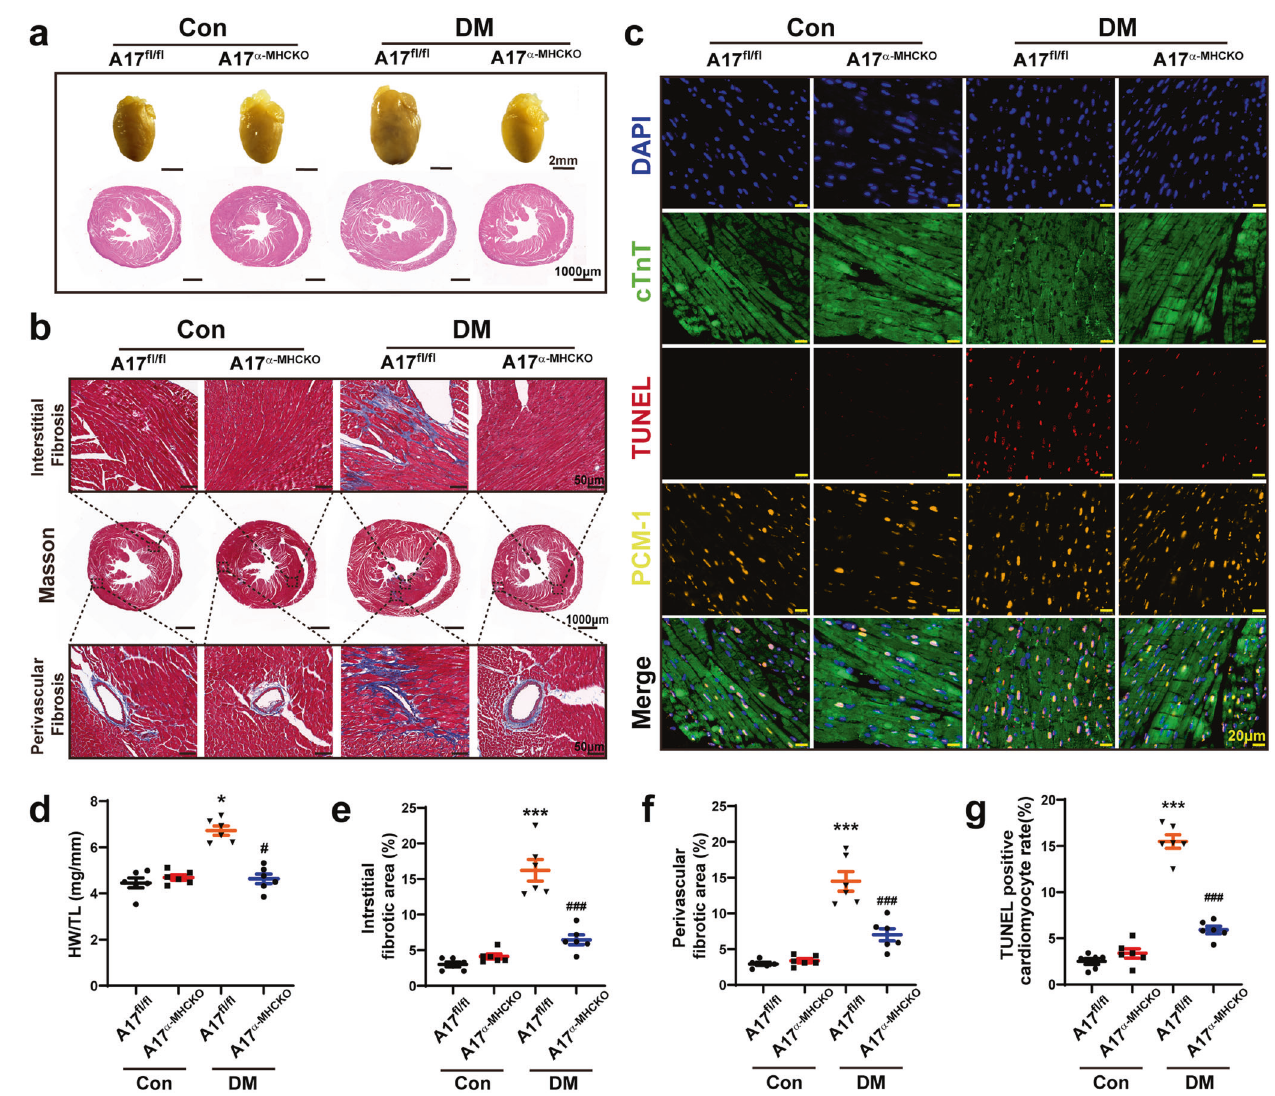
Fig. 2 Histological and immunohistochemical staining in four groups of mice. a Representative images of hearts and myocardial cross- sections in four groups of mice: representative heart pictures (scale bar: 2 mm) were shown in the upper panel; Representative H&E staining of myocardial cross-sections (scale bar: 1000 μ m) were shown in the lower panel. b Representative Masson ’ s trichrome staining of myocardial fi bers. Masson ’ s trichrome staining of cardiac short-axis cross sectional areas (scale bar: 1000 μ m) were shown in the middle panel. Dotted boxes in the middle panel indicated a local area in the low magni fi cation fi eld (scale bar: 1000 μ m), which was enlarged in the high magni fi cation fi eld (scale bar: 50 μ m) in the bottom panel. The interstitial fi brosis images were shown in the top panel and the perivascular fi brosis images were shown in the bottom panel. c Representative TUNEL-positive cardiomyocyte staining in mice (scale bar: 20 μ m). d Quantitative analysis of heart weight/tibial length (HW/TL) ratio in mice, n = 6. e and f Quanti fi cation of the interstitial and perivascular fi brosis area in mice, n = 6. g Quanti fi cation of TUNEL-positive cardiomyocytes in mice, n = 6. Data were expressed as mean ± SEM. * P < 0.05, *** P < 0.001 vs. the A17 fl / fl control group; # P < 0.05, ### P < 0.001 vs. the A17 fl / fl DM